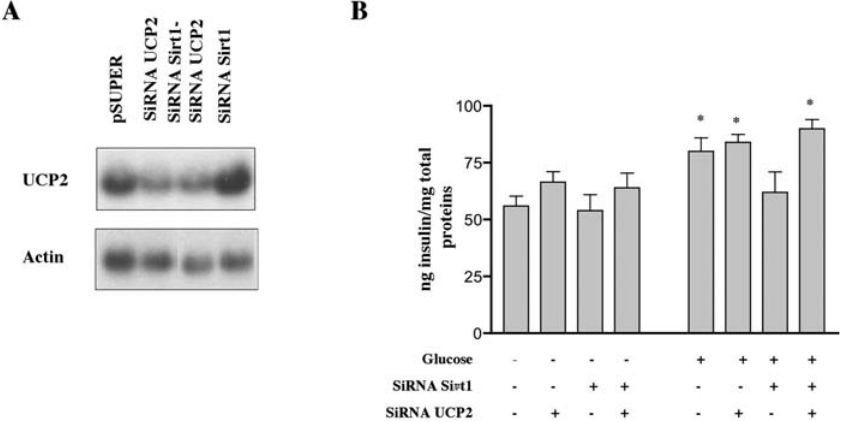
Figure 6. Knockdown of UCP2 in Sirt1 Knockdown Cells Restores Glucose-Induced Insulin Secretion (A) Northern blot for UCP2 RNA in control INS-1 cells, and cells knocked down for Sirt1 (SiRNA Sirt1), UCP2 (SiRNA UCP2), or both Sirt1 and UCP2 (SiRNA Sirt1-SiRNA UCP2). RNAs were quantitated by densitometry, setting the level of UCP2 in control cells at 1.0. (B) Insulin secretion in INS-1 control cells and cells with knockdown levels of Sirt1, UCP2, or both Sirt1 and UCP2 after treatment with 16.7 mM glucose ( þ ) or 4mM glucose ( (cid:1) ) for 1 h ( n ¼ 3 experiments done in triplicate, * p , 0.05 in SiRNA Sirt1-SiRNA UCP2, ANOVA). DOI: 10.1371/journal.pbio.0040031.g006